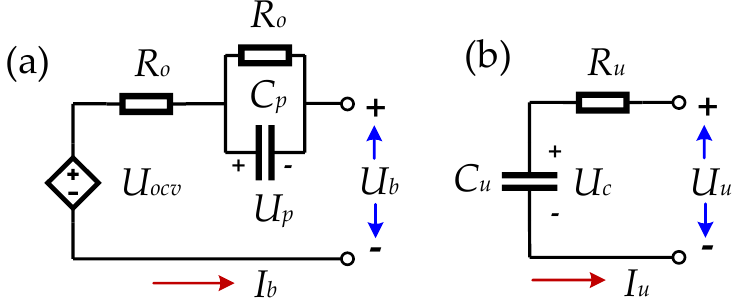
Figure 2. ( a ) Thevenin model of the lithium-ion battery. ( b ) Standard RC model of the